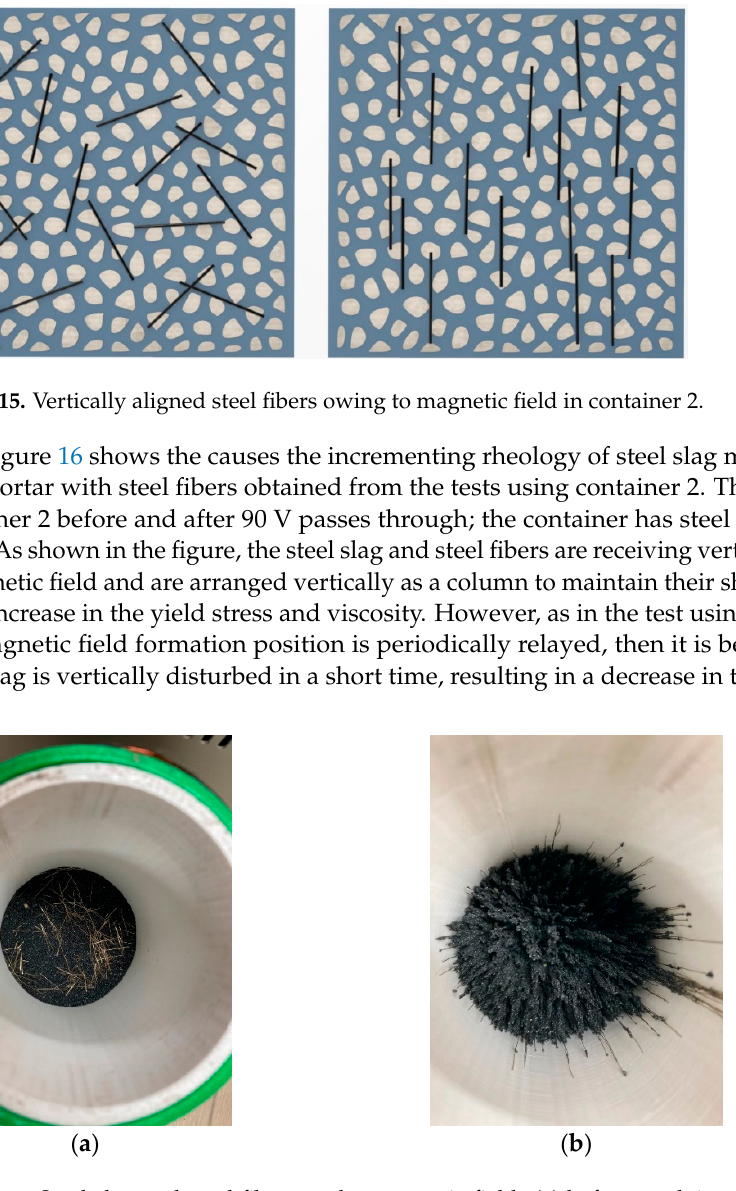
16 of 19 ( b ) Figure 14. Viscosity results from Phase II test: ( a ) at 50 V, ( b ) at 90 V. The viscosity of SSM_SF1 (0.25) was not significantly reduced in containers 1 and 2 but decreased significantly in container 3. This result demonstrates that the rheology of SSM and SSM_SF is significantly affected by the application method of the magnetic field. In particular, in container 3, because the application position of the magnetic field is re- layed over time, the magnetic force that pulls the steel slag and the steel fiber acts accord- ing to the position relayed, resulting in an increase in the fluidity of the SSM and a conse- quent decrease in the yield stress and viscosity. 4. Discussion The magnetic field applied to container 1 significantly reduced the rheology of the normal mortar with steel fibers so that the rheology of the normal mortar with the steel fibers became almost the same as that of the mortar without steel fibers. However, this effect was not observed in the results for the steel slag mortar and steel slag mortar with